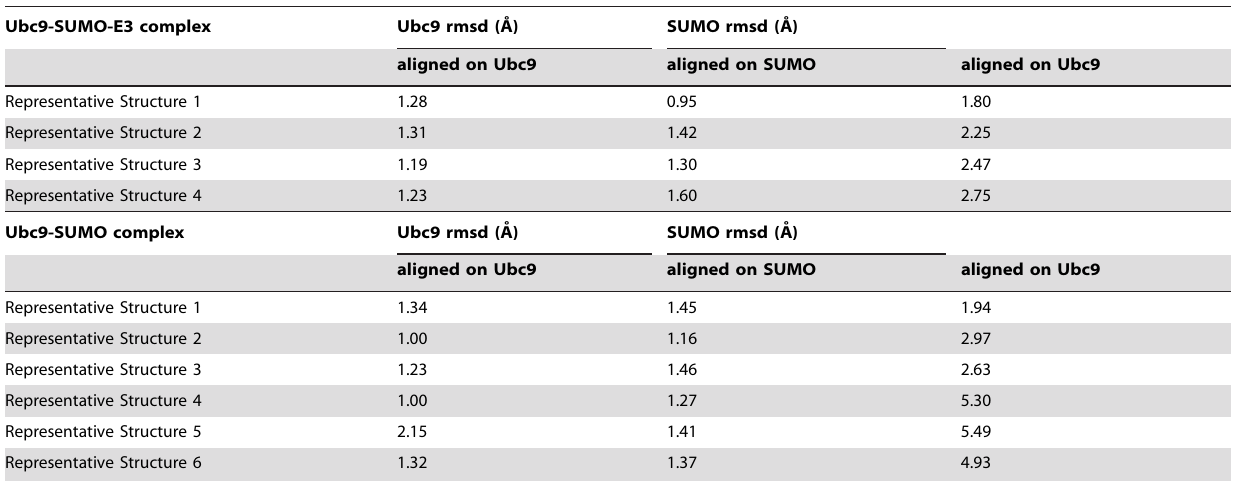
Table 1. RMSD with chain based alignments.